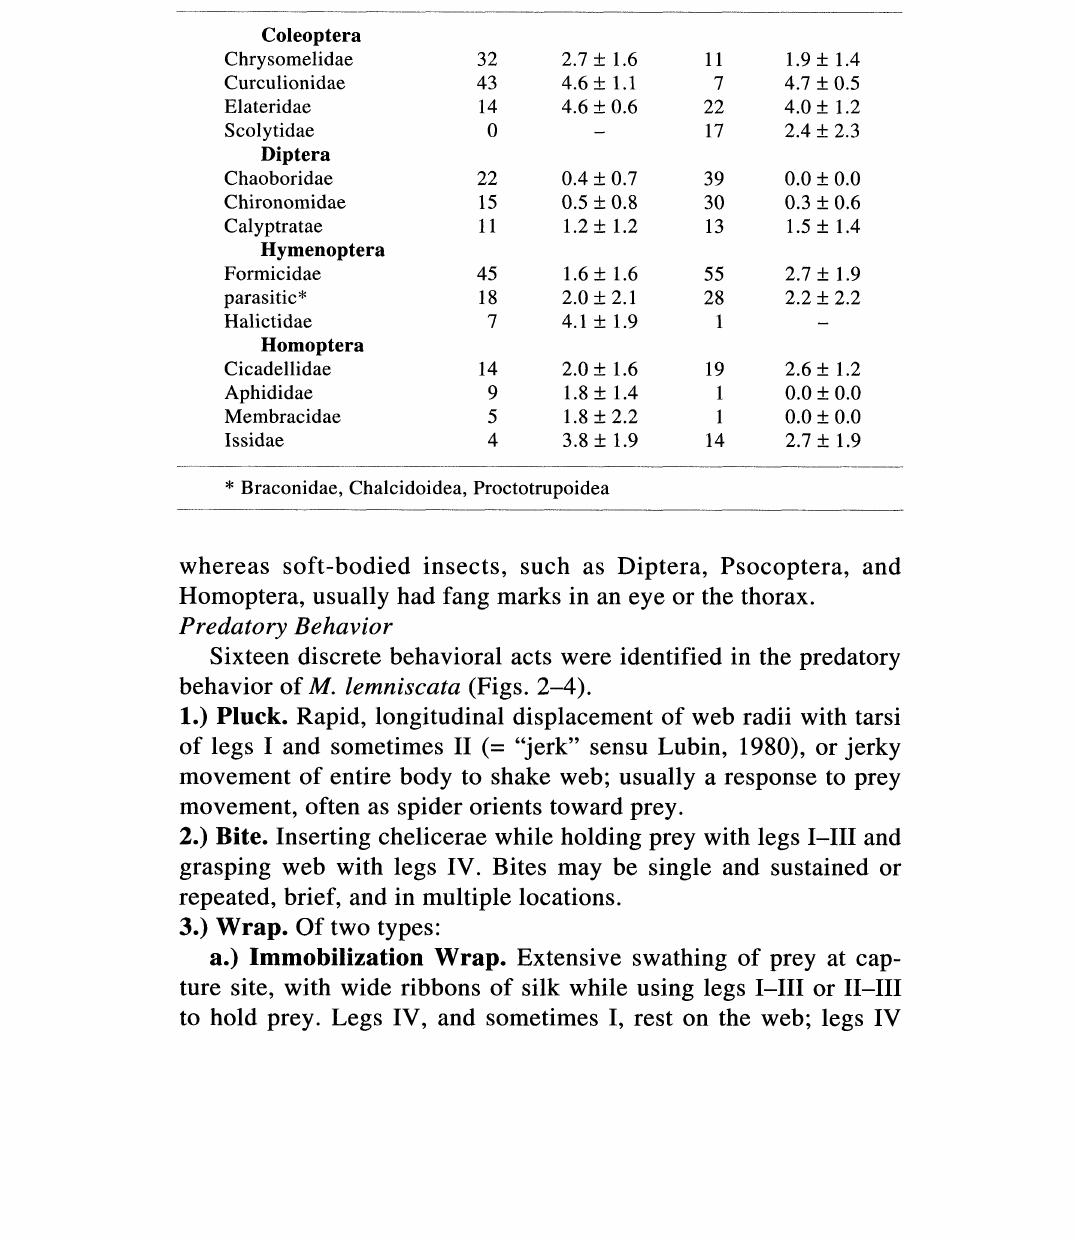
Table 1. Wrap index (mean + SD) for dominant prey captured in field webs of M. lemniscata.